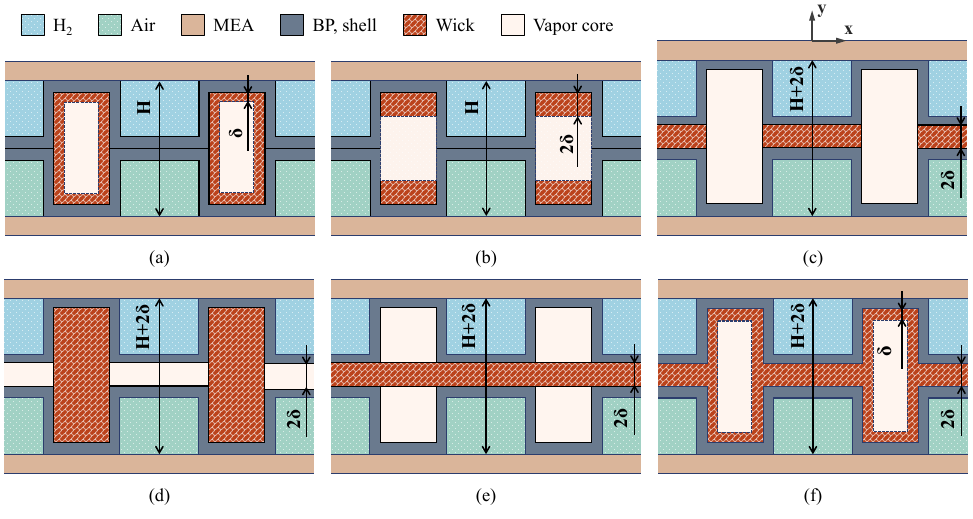
Figure 2. Schematics of the HPBPs with different internal structures: ( a ) Layered structure. ( b ) Modi- fied layered structure. ( c ) Spaced structure with large vapor core. ( d ) Spaced structure with small vapor core. ( e ) Modified spaced structure. ( f ) Composite structure.